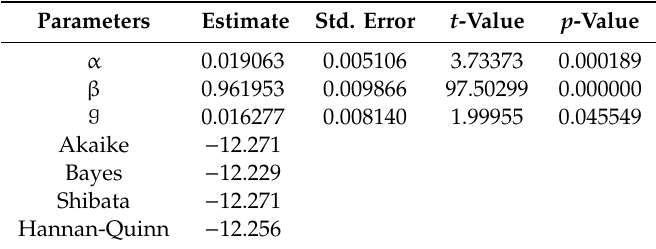
Table A1. Parameter Estimates of Hong Kong’s Islamic-conventional ADCC-GARCH model. Table A2. Parameter Estimates of New Zealand’s Islamic-conventional ADCC-GARCH model. Table A3. Parameter Estimates of China’s Islamic-conventional ADCC-GARCH model. Figure A4. Islamic-conventional stock returns Wavelet correlations for Americas’ region markets.